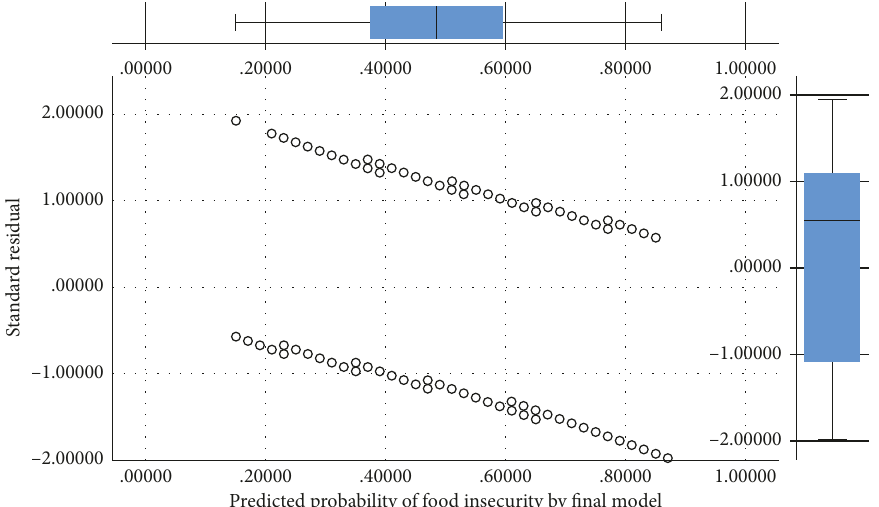
Figure 1: Binned standardized residuals versus predicted probabilities to check model